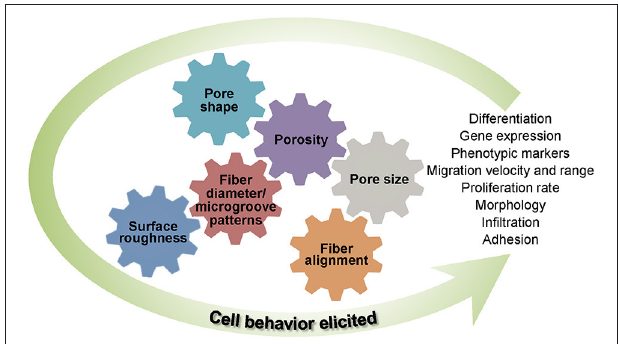
FIGURE 3 | Important structure and morphology scaffold parameters affecting cell